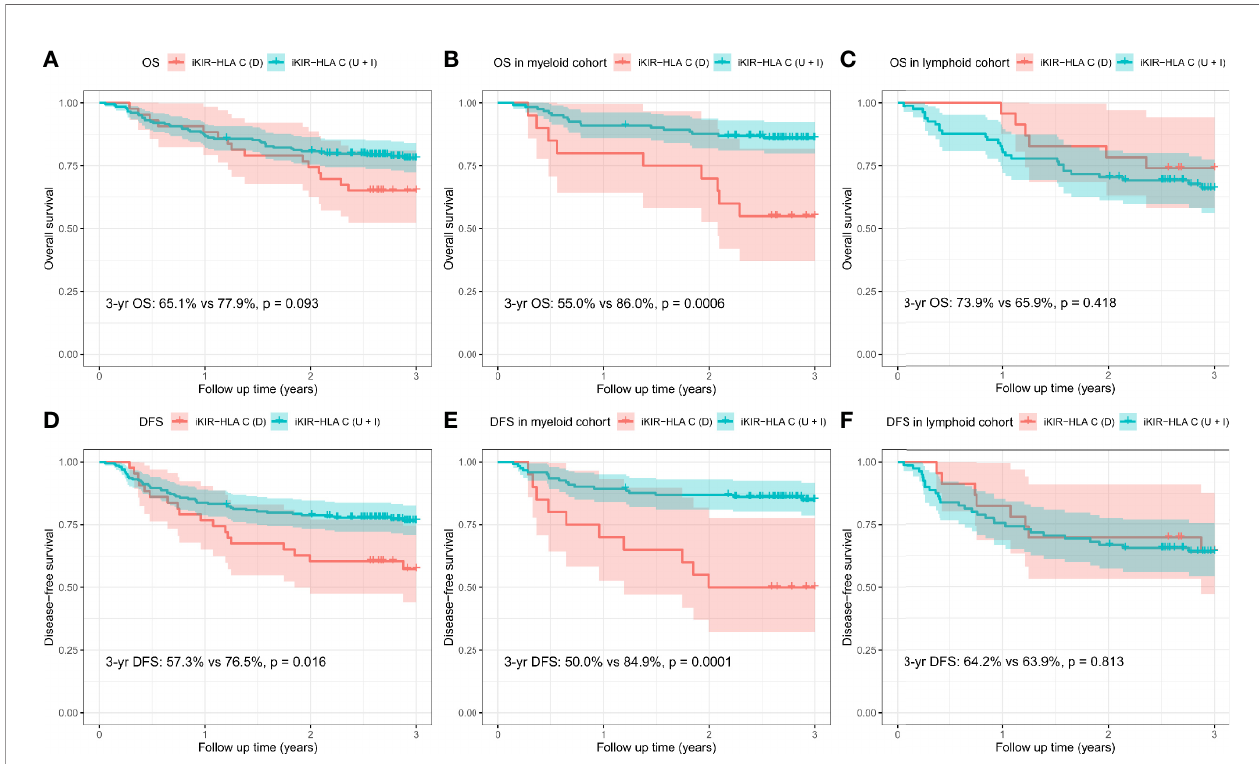
FIGURE 2 | Overall survival (OS) and disease-free survival (DFS) rates for all patients (A, D) , the myeloid cohort (B, E) , and the lymphoid cohort (C, F) , based on the variation (D, decreased; U, unchanged; I, increased) in their iKIR-HLA C pair